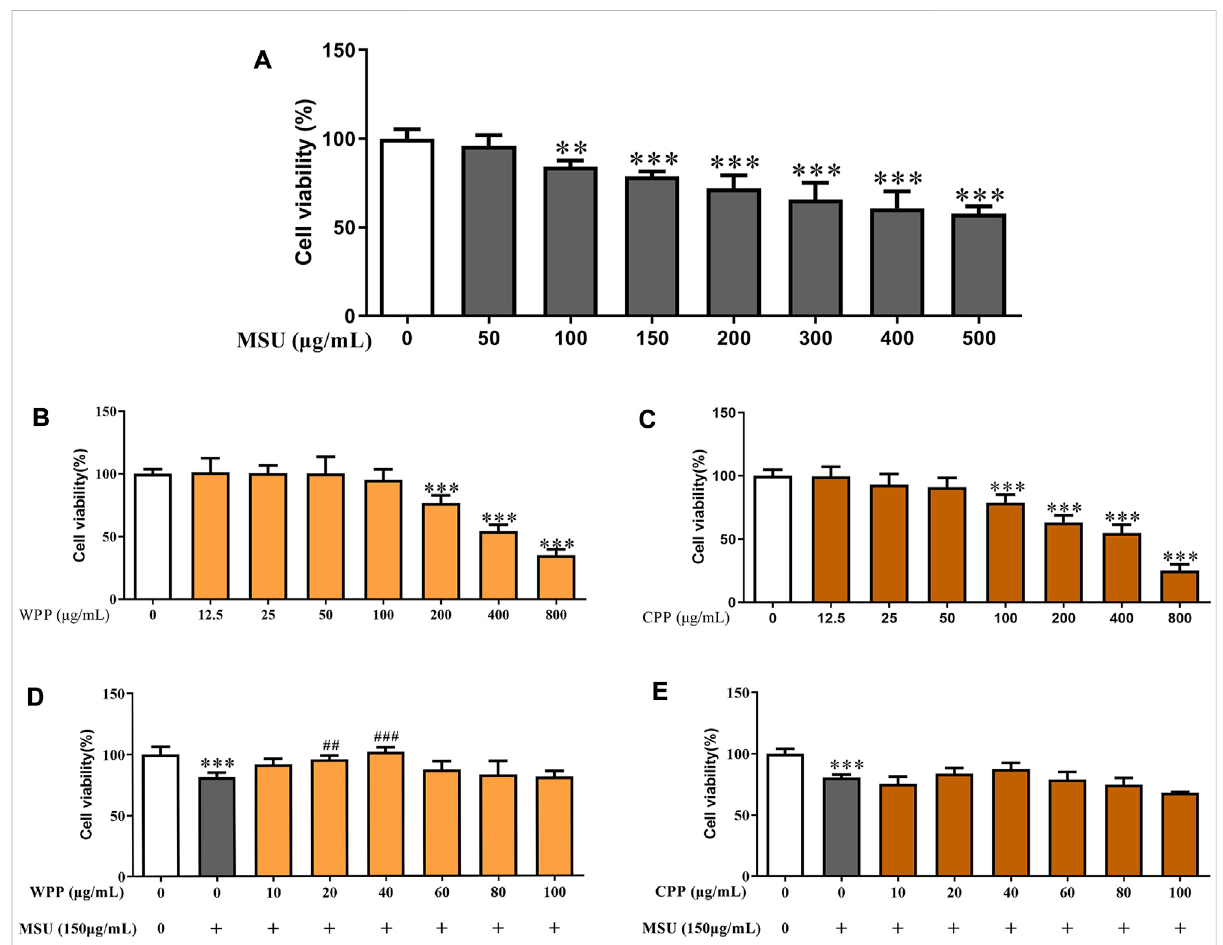
FIGURE 2 The effects of MSU on cell viability, * p < 0.05, ** p < 0.01, *** p < 0.001 vs. the control group, n = 6 (A) . Cell viability of HUVECs treated with different concentrations of WPP as determined by the MTT assay, *** p < 0.001 vs. the control group, n = 6 (B) . Cell viability of HUVECs treated with differentconcentrationsofCPPasdeterminedbytheMTTassay,*** p < 0.001vs.controlgroup; n =6 (C) .ProtectiveeffectofWPPonMSU-induced HUVEC injury, *** p < 0.001 vs. control group; ## p < 0.01, ### p < 0.001 vs. positive group, n = 6 (D) . Protective effect of CPP on MSU-induced HUVEC injury, *** p < 0.001 vs. the control group, n = 6 (E)